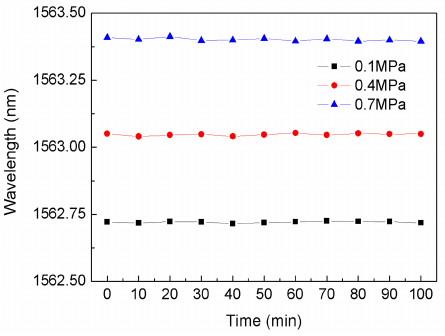
Figure 8. The stability test results of the proposed sensor at 0.1, 0.4 and 0.7 MPa under 800 ◦ C for 100